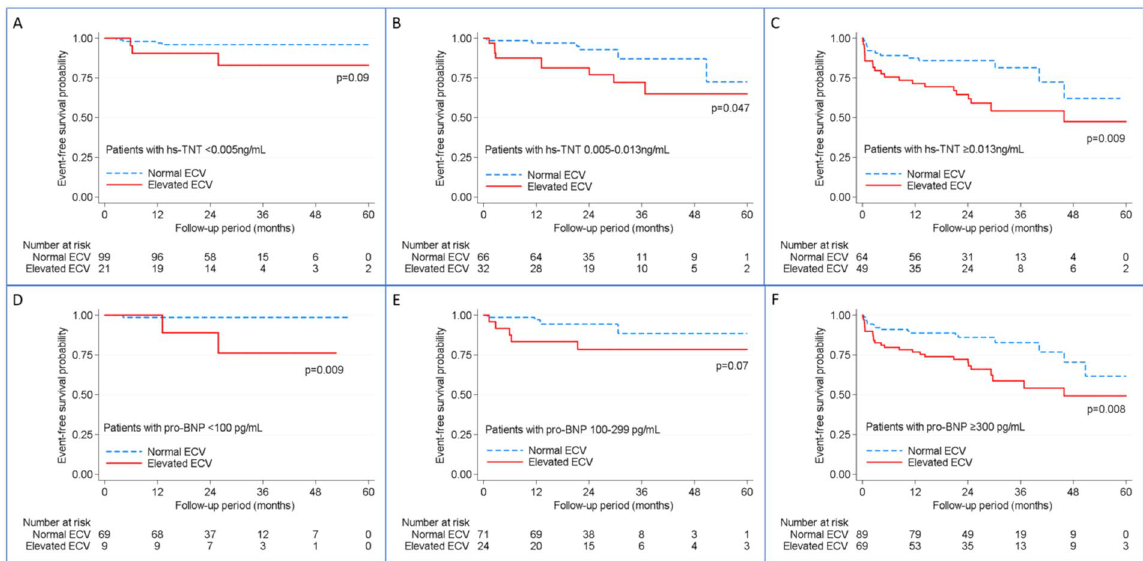
Figure 1. Kaplan-Meier survival curves are shown demonstrating event-free survival from a first composite heart failure event stratified by normal (dashed blue) vs. elevated extracellular volume (ECV) (solid red). The cohort was separated by categories of high-sensitivity troponin levels (hs-TNT) (top row, A–C ) and by categories of N-terminal pro B-type natriuretic peptides (pro-BNP) (bottom row, D–F ) based on recommended commercial cutoff